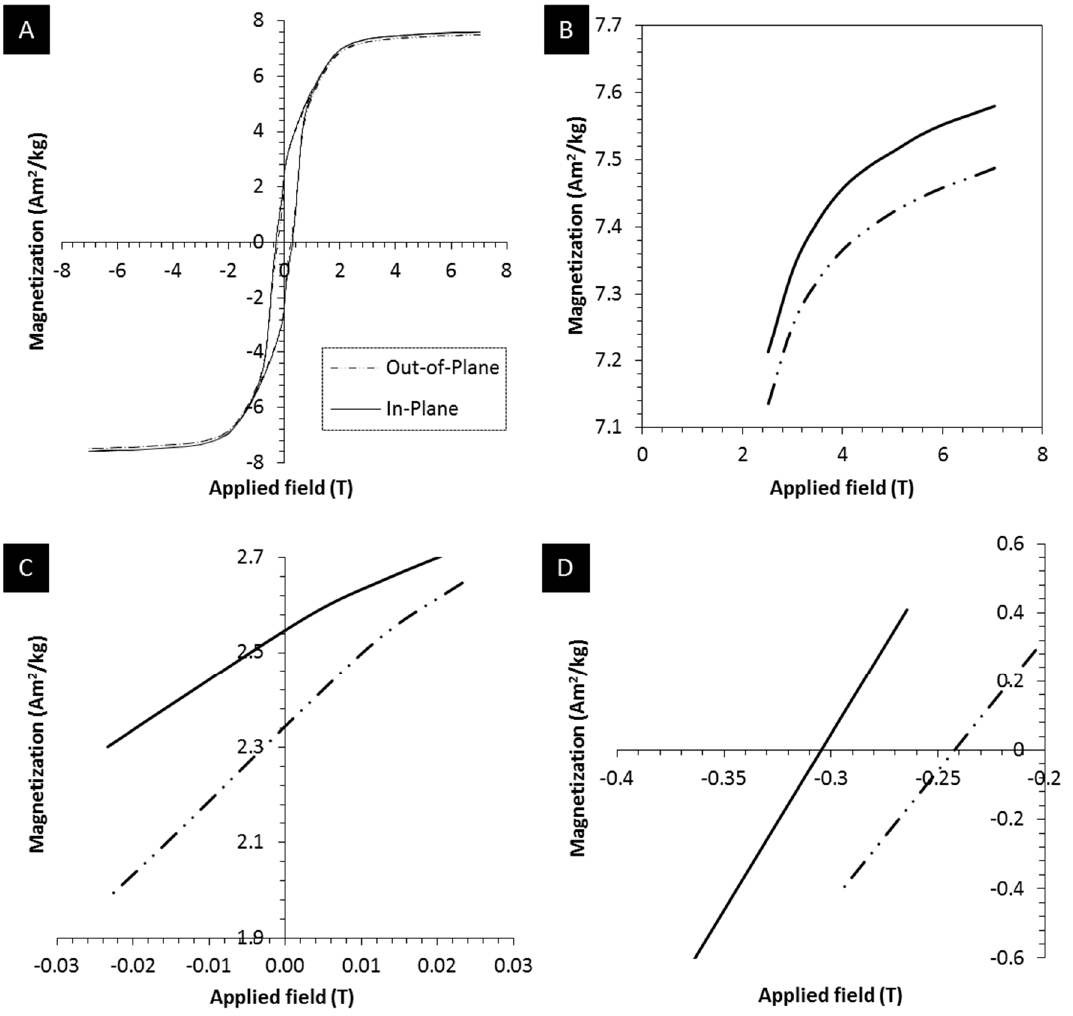
Figure 13. ( A ): Hysteresis data for magnetization versus applied magnetic field; ( B ), ( C ), and ( D ): Magnified views of hysteresis graph for saturation magnetization, magnetic remanence, coercivity, respectively.